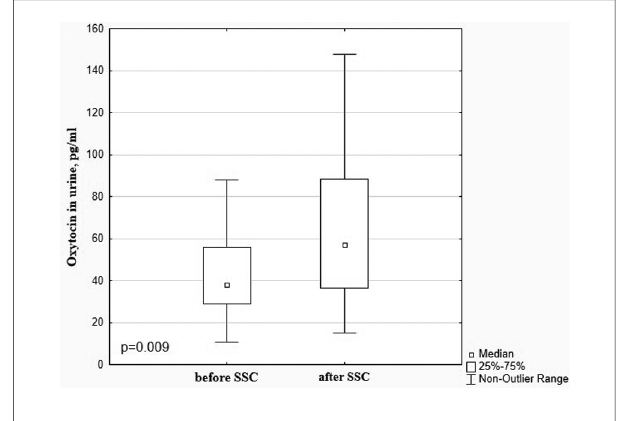
FIGURE 4 Oxytocin in the urine in preterm infants before and after SSC.